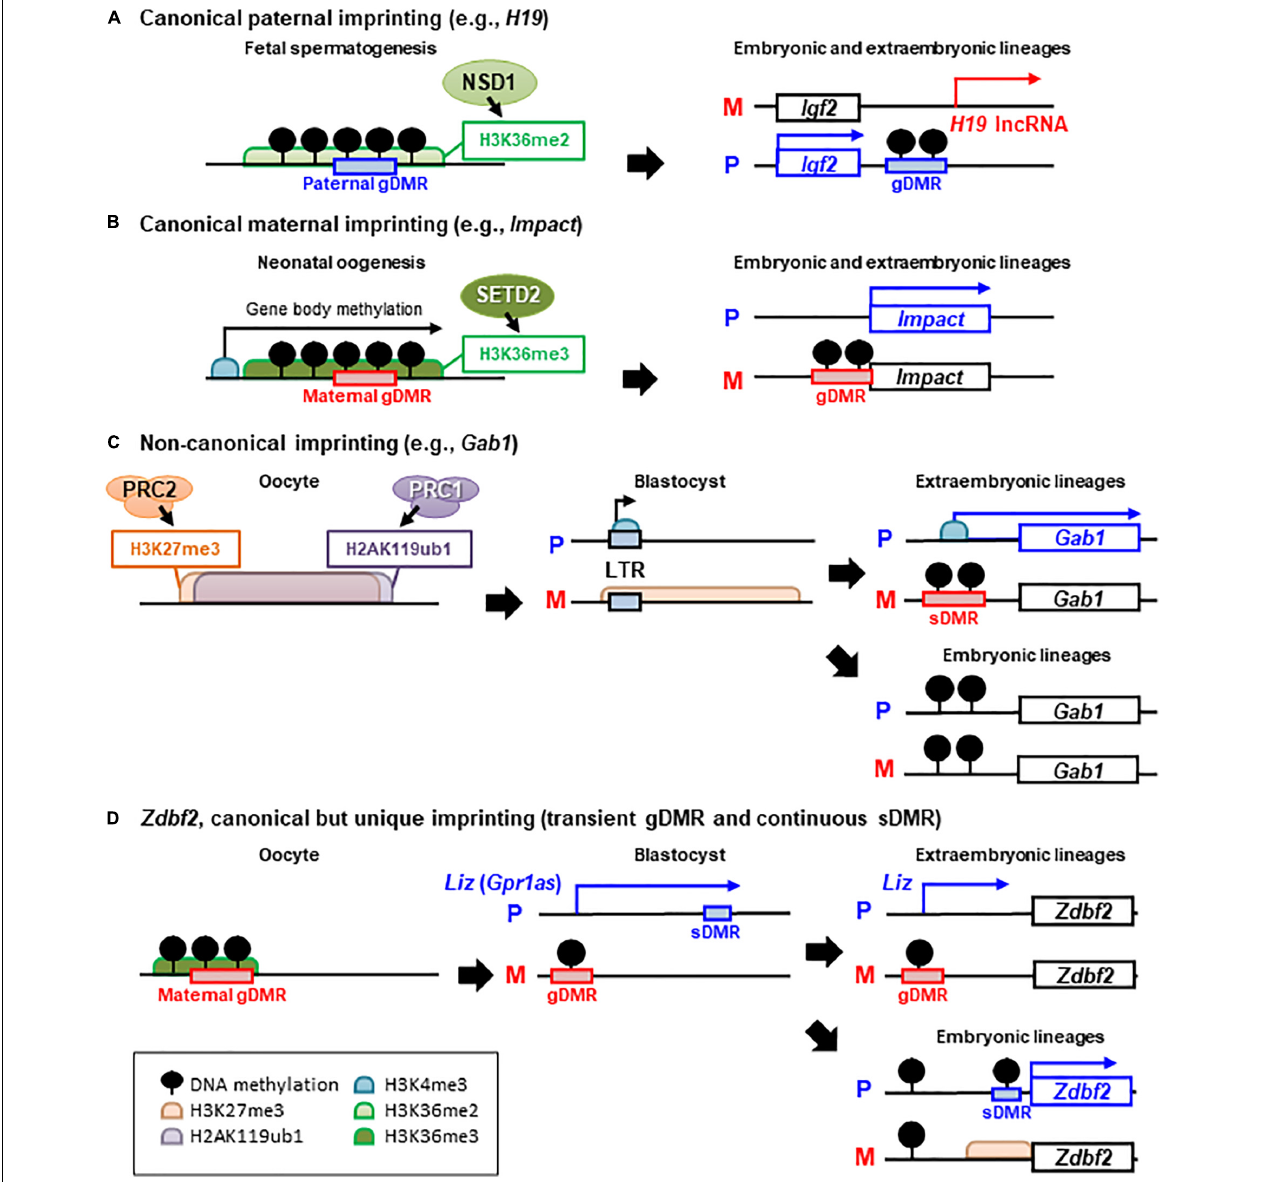
FIGURE 1 | Epigenetic mechanisms of canonical and non-canonical imprinted gene regulation. There are several examples of different epigenetic inheritance patterns between paternal (P) and maternal (M) alleles, that control paternally expressed protein-coding genes. (A) Paternal and (B) maternal germline differentially methylated region (gDMR)-mediated canonical imprinting. H3K36 methyltransferases NSD1 and SETD2 have been shown to establish H3K36me2 or H3K36me3 in pro-spermatogonia or oocytes and to be required for de novo DNA methylation at paternal or maternal gDMRs, respectively. In general, canonical imprinting is stably maintained throughout somatic life and mediates monoallelic silencing of imprinted genes or non-coding RNAs. (C) Non-canonical imprinting, such as Gab1 loci. H2AK119ub1 guides maternal inheritance and zygotic deposition of H3K27me3, and thus, maternally inherited H3K27me3 is maintained until the blastocyst (pre-implantation) stage. Then, maternal H3K27me3 silences the LTR retrotransposon-derived alternative promoter, which becomes actively transcribed on only the paternal allele. Although maternal H3K27me3 is lost after implantation, maternal allele-specific DNA methylation is established as an imprinted sDMR in extra-embryonic tissues, and thus, monoallelic paternal expression of non-canonically imprinted LTRs and nearby protein-coding genes can be maintained. In the post-implantation epiblast, these ERVs are silenced by DNA methylation in both alleles, resulting in a loss-of-imprinting in somatic lineages (not shown in the figure). (D) Zdbf2 locus is a unique example of secondary imprinting. Transient paternal allele-specific expression of a long isoform transcript of Zdbf2 ( Liz , also called Gpr1as ) originated from the maternal gDMR, occurs in the pre-implantation embryo. Liz continues to be paternally expressed by the persistence of the maternal gDMR in extra-embryonic tissues. In the embryonic tissues, maternal gDMR is biallelically methylated and loses its imprinted status and Liz transcription; However, Zdbf2 retains imprinted expression because of acquired paternal DNA methylation at the sDMR and active H3K4me3 at the Zdbf2 promoter via traversing Liz transcription during